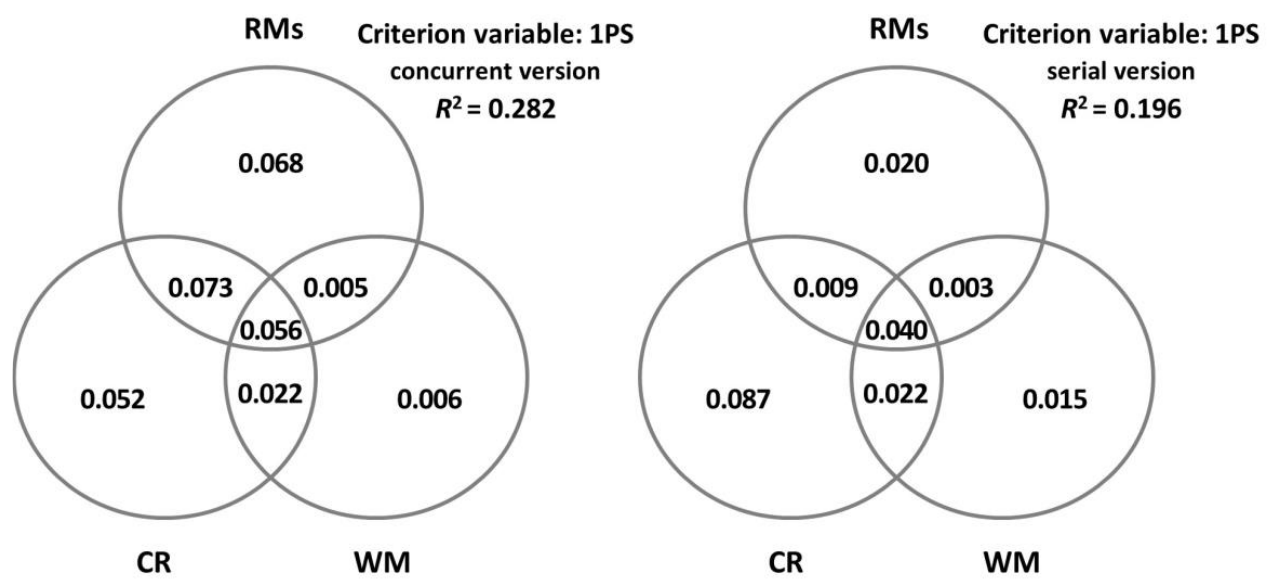
Figure 5. Decomposition of the variance in one-proposition sentences (1PS) explained jointly and uniquely by cognitive reserve (CR), measured by the cognitive reserve questionnaire (CRQ); working memory (WM), measured by the digit ordering task (DO); and the rest of the measures (RMs: age, MMSE, GDS-15, and MFE).